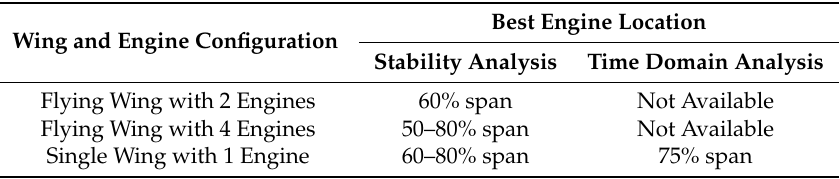
Table 1. Best engine location obtained from stability and time domain